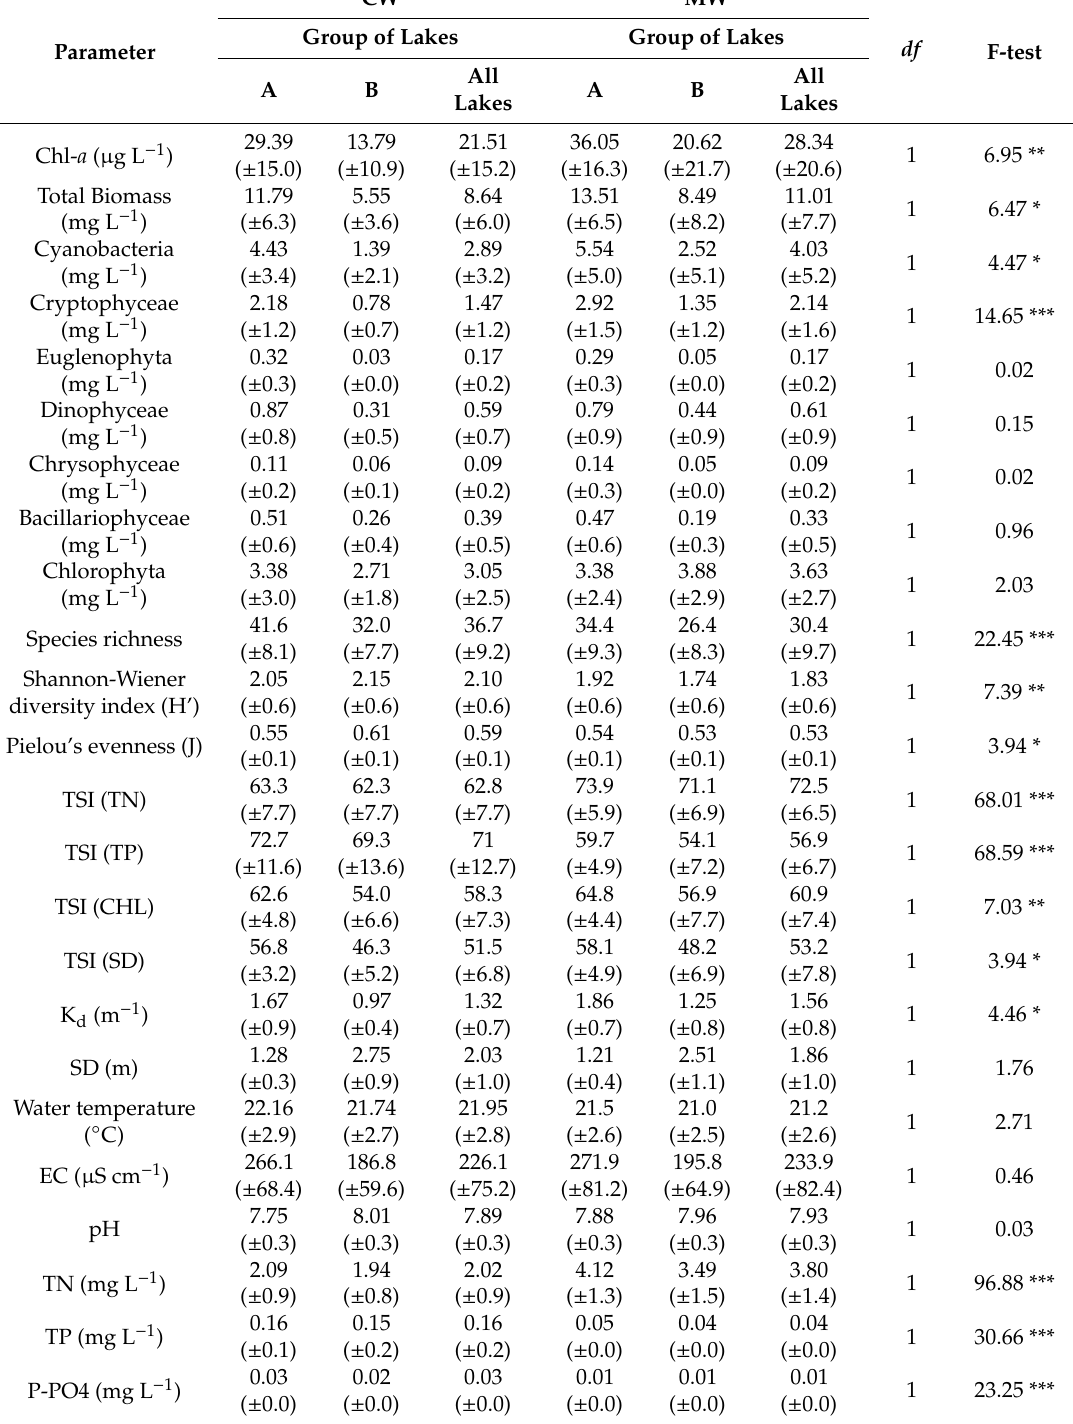
Table 2. Mean values ( ± standard deviations) of the biological, physical and chemical parameters compared between the growing seasons after a cold (CW) and mild winter (MW) in the best-fitting two-way ANOVA model. Selected e ff ects related to the types of winter are presented below. Explanations: A—mean values for Lakes Gł˛ebokie and Gumienek; B—mean values for Lakes Czarne and